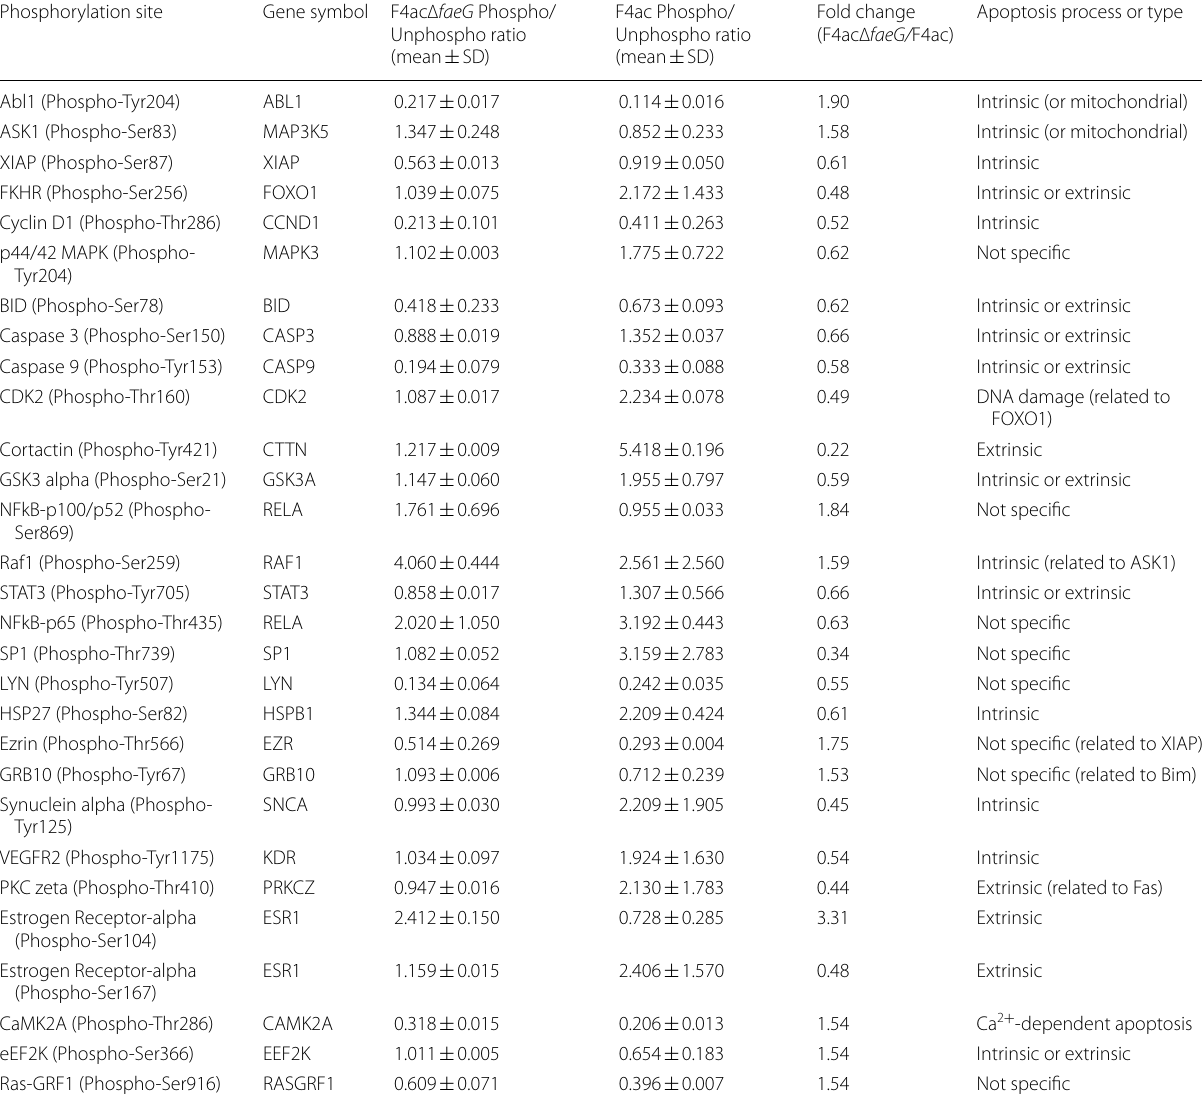
Table 1 Phospho/Unphospho Ratio change in F4ac∆ faeG vs F4ac infected cells Phosphorylation